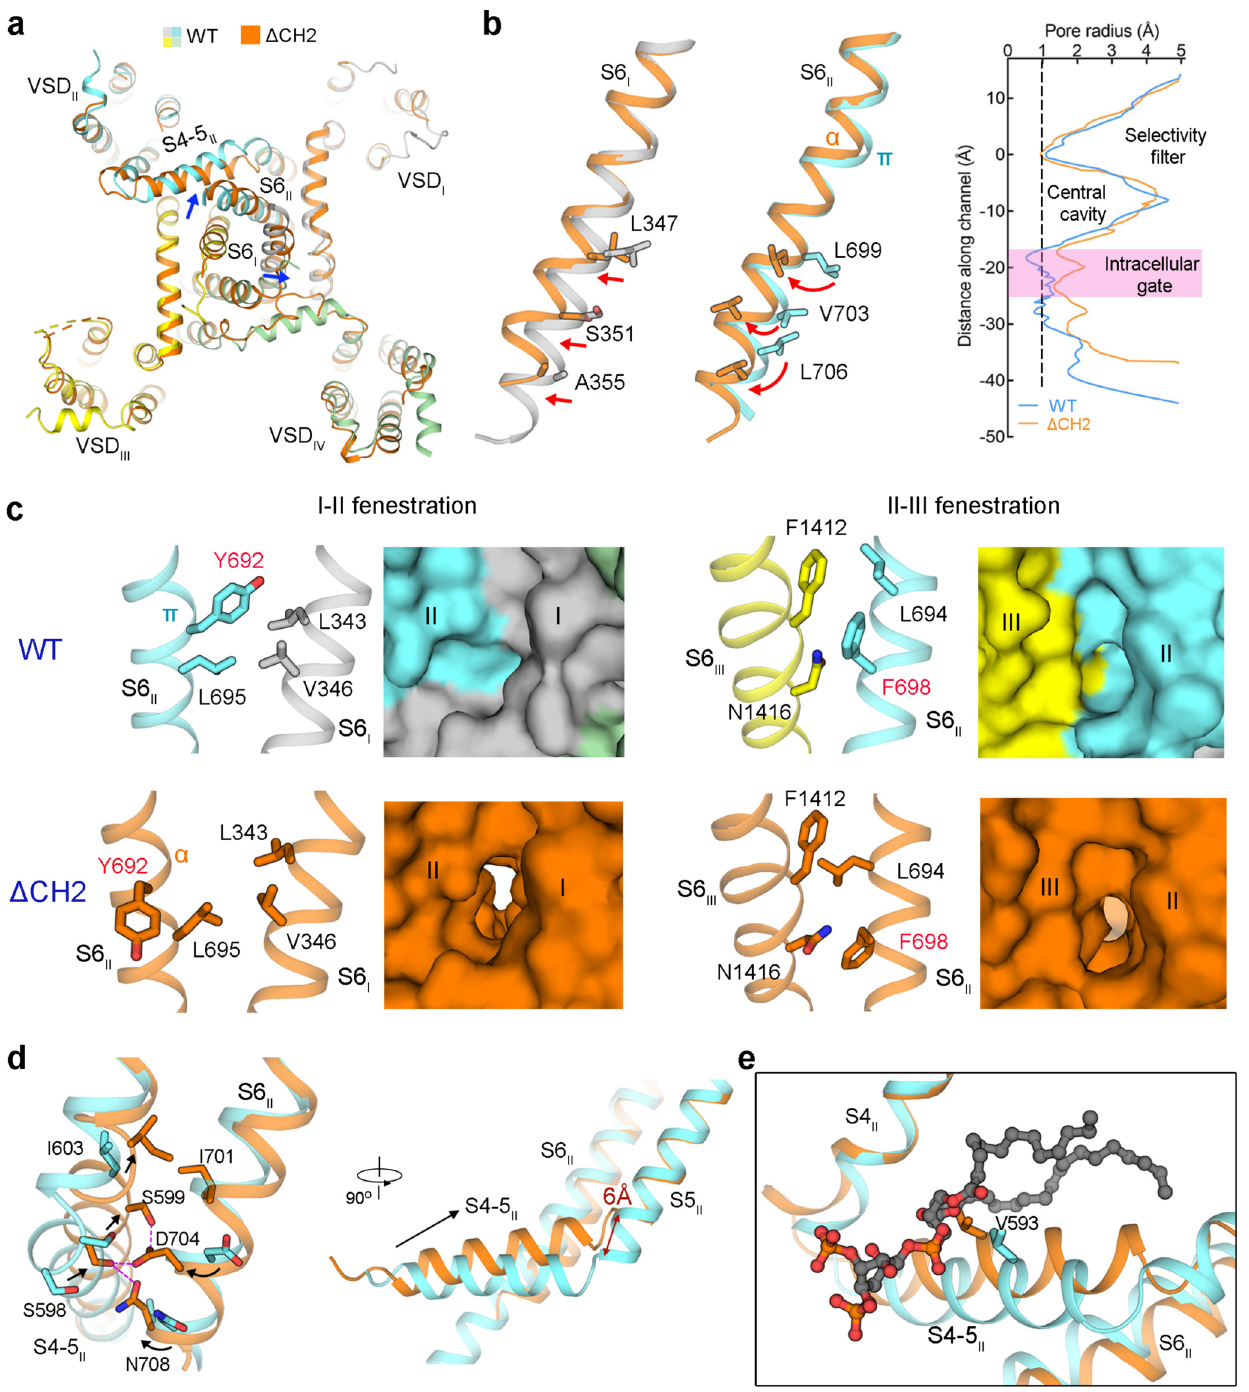
Fig. 4 | Conformational changes of the PD upon CH2 deletion. a In the super- the axial rotationof S6 II thatturns Tyr692and Phe698 (labeled red)awayin Δ CH2. d Rotations of Asp704 and Asn708 on S6 II induce the upward motion of S4-5 II and imposed α 1structuresofWTand Δ CH2Ca v 2.3,S6 I ,S6 II and S4-5 II segmentsexhibit evidentconformationalchanges.BluearrowsindicatethestructuralshiftsfromWT its joint with S5 II . Purple dashes indicate the H-bonds between Ser588 and Ser589 on S4-5 II with Asp704 and Asn708 on S6 II . Structural shifts of the interacting resi- to Δ CH2. b The gating residues on S6 I displace outwards (left), while those on S6 II undergo an axial rotation (middle). The structural shifts of gating residues from dues are indicated by black arrows. Right: The hinge between S4-5 and S5 II moves WT to Δ CH2 are indicated by red arrows. A secondary structure transition from towardthemembranebyadisplacementof~6Å. e ThelocalshiftofS4-5 II segment π → α occurs in S6 disfavors PIP2 binding. The upward movement would lead to potential clash with II . Right: In the absence of CH2 II , the intracellular gate becomes PIP2 looselyclosed.TheporeradiiarecalculatedbyHOLE 53 .Sourcedataareprovidedas aSourceData fi le. c OpeningoftheI-II(left)andII-III(right)fenestrationsitesupon